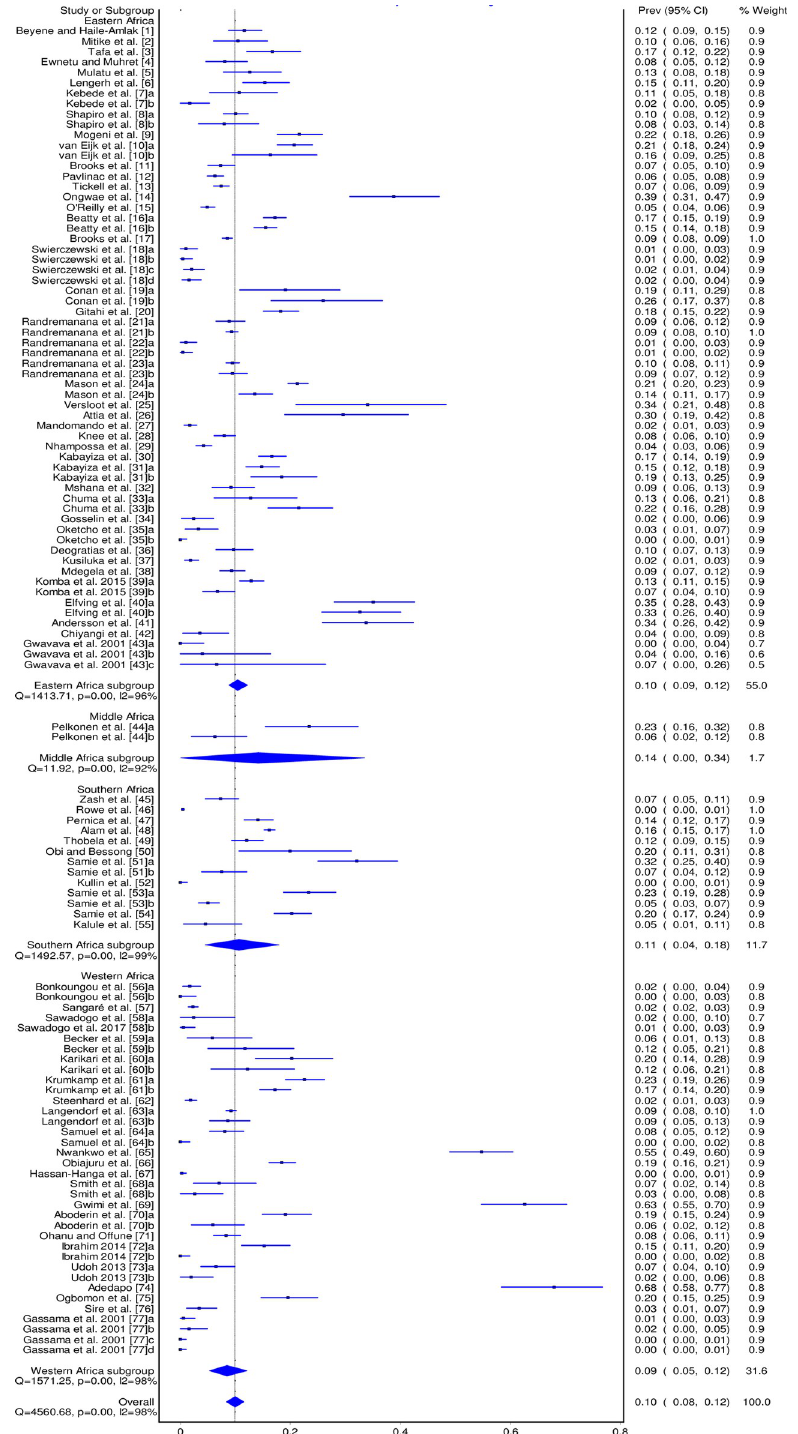
Fig 2. Forest plot of Campylobacter spp. pooled prevalence in humans in sub-Saharan Africa between 2000 and 2020.